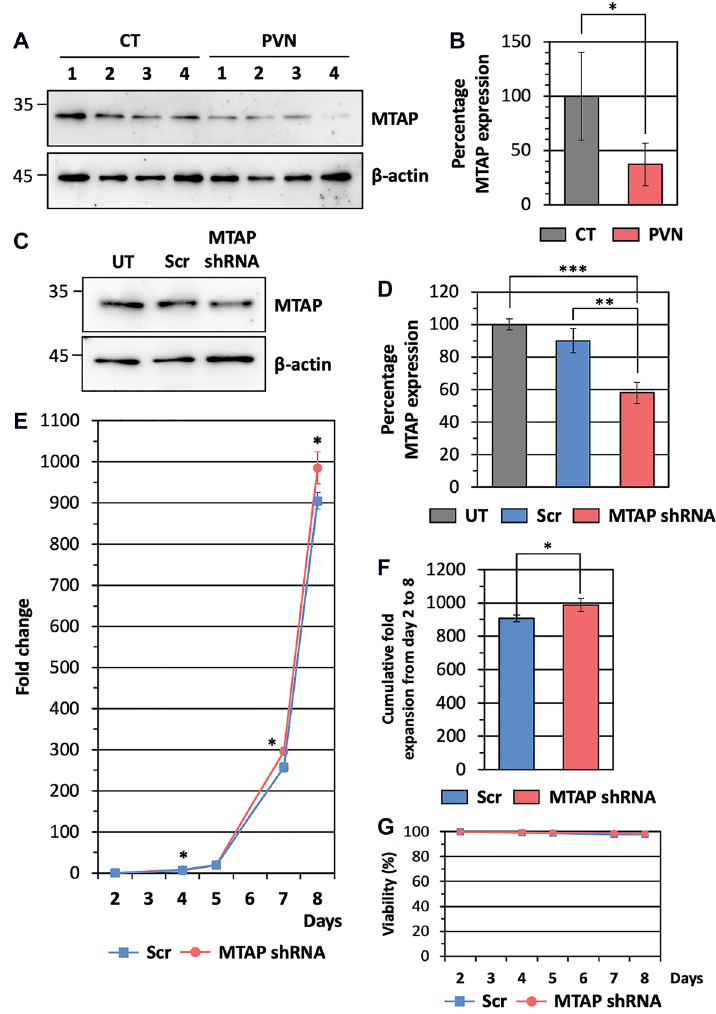
Figure 4. MTAP knockdown enhances proliferative capacity in normal erythroblasts. ( A ) Representative visualised bands of MTAP and a loading control β-actin from western blot of day 7 erythroid cells from newly-diagnosed PV patients (PVN) and healthy subjects (CT). ( B ) Density of MTAP bands on Western blots (in A ) were quantified using ImageJ normalized to β-actin, mean ± SD of four independent cultures. ( C – G ) Erythroblasts differentiated from adult peripheral CD34 + cells were transduced with MTAP shRNA or control scrambled shRNA (Scr) on day 2 in culture. Untransduced cells (UT) served as a control. ( C ) Representative visualised bands of MTAP and a loading control β-actin from western blot at 72 h post-transduction. ( D ) Density of MTAP bands on Western blots (in C ) were quantified using ImageJ normalized to β-actin, mean ± SD of three independent cultures. ( E ) Fold-expansion from day 2 to 8 in culture, mean ± SD of three independent cultures. ( F ) Cumulative fold expansion from day 2 to 8 in culture, mean ± SD of three independent cultures. ( G ) Viability from day 2 to 8 in culture, mean ± SD of three independent cultures. * p -value < 0.05, ** p -value < 0.01, two-tailed t